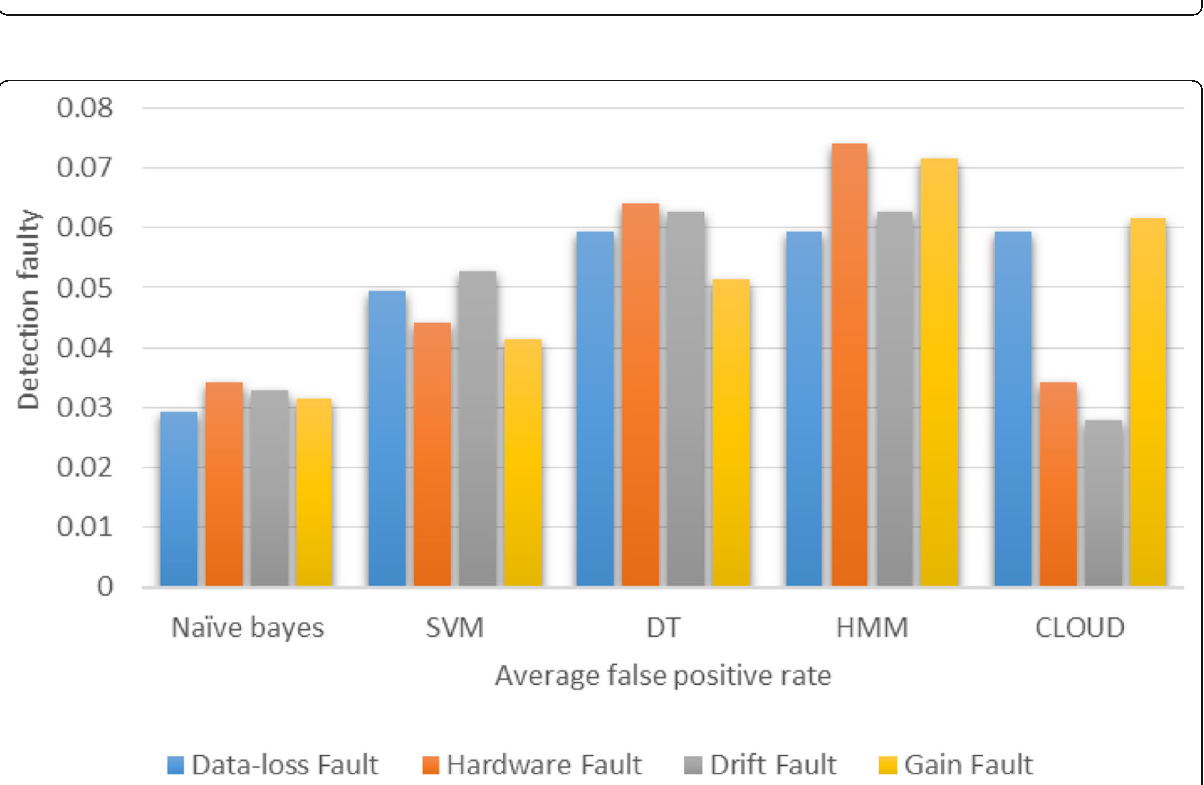
Fig. 9 Comparison of the proposed method for the classification of collecting data with the SVM [26], DT [36], HMM [38] and the CLOUD [33] on the data-loss fault